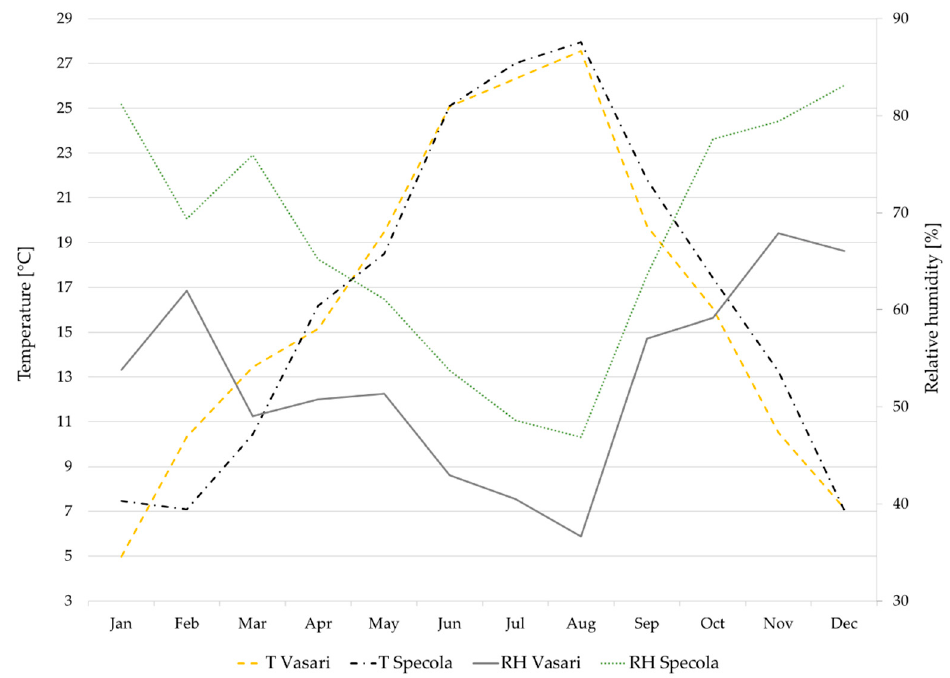
Figure 5. Vasari Corridor and La Specola: trend of monthly average outdoor air temperature (T) and relative humidity (RH).